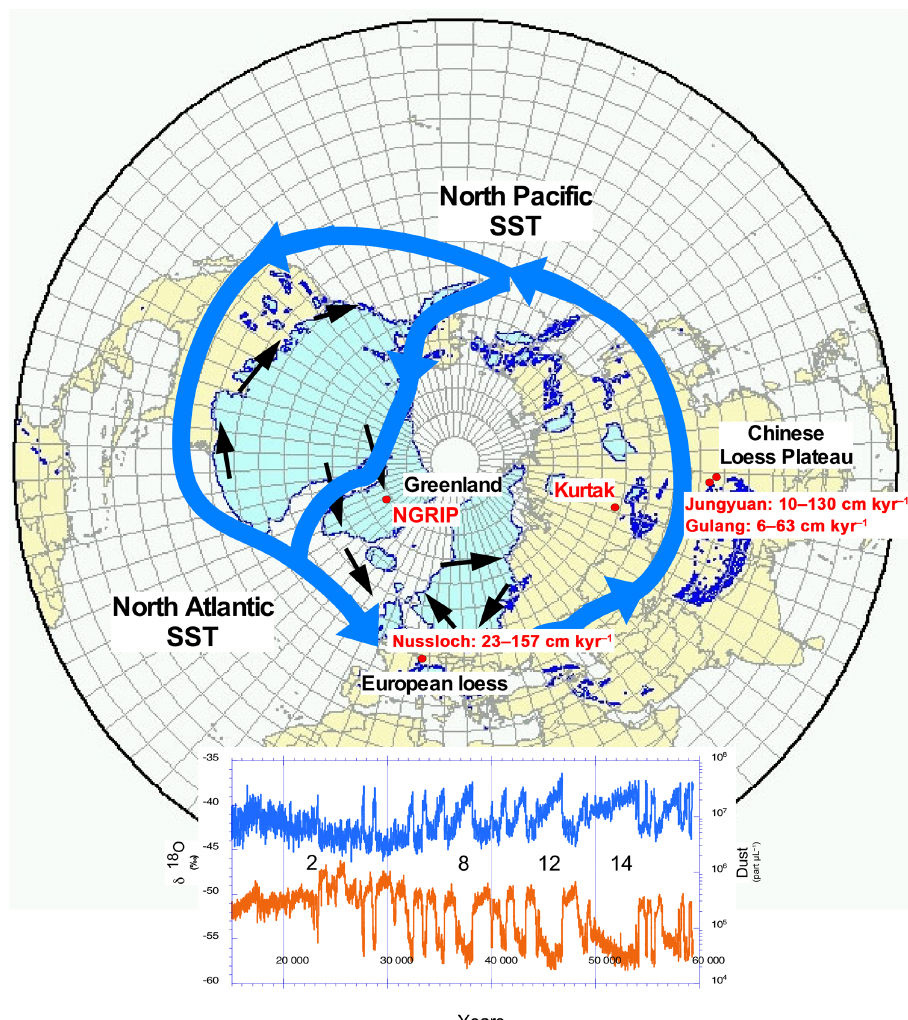
Figure 4. Map of the maximum extension of the last climate cycle ice sheets in northern Europe. Schematic location of the polar jet stream with location of regions or areas (in black) and of sites (in red) discussed in the text. δ 18 O (‰, in blue) and the dust concentration (part/µL, in brown) records in the NGRIP ice core over the interval between 60ka and 15kab2k. Dust concentrations are shown on a logarithmic scale. Map was compiled by Jürgen Ehlers available at